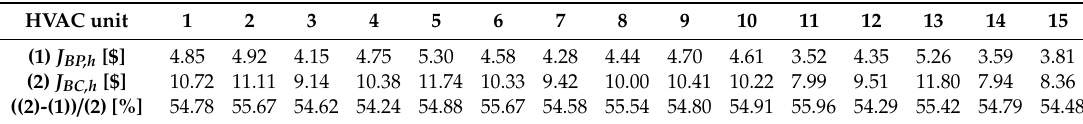
Table 3. Reductions of the operating costs ( J BP,h and J BC,h ) for individual HVAC units. HVAC unit